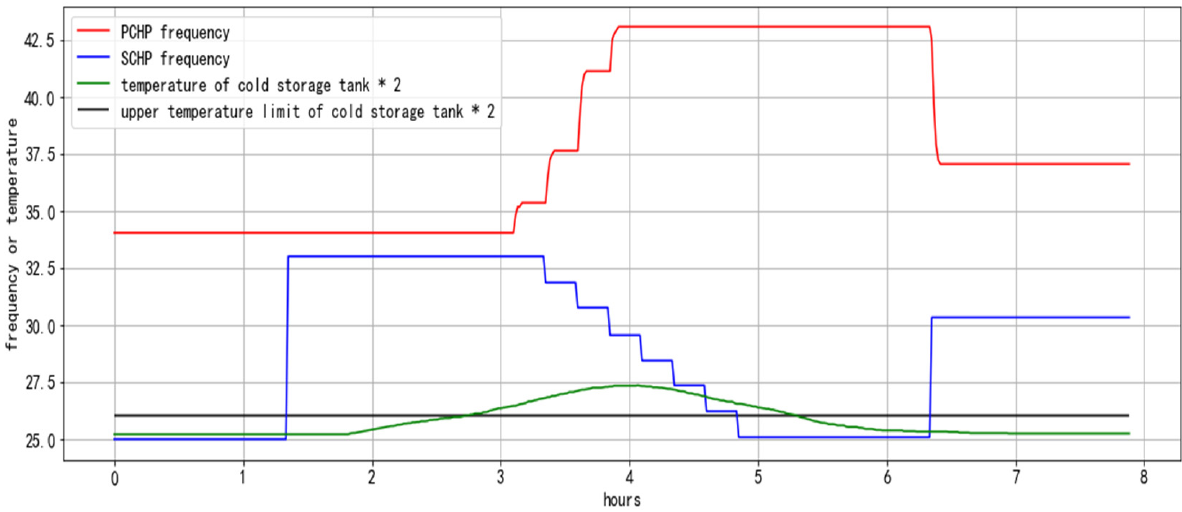
Figure 5. The online feedback constraint correction process for the temperature of cold storage tanks in a data center.